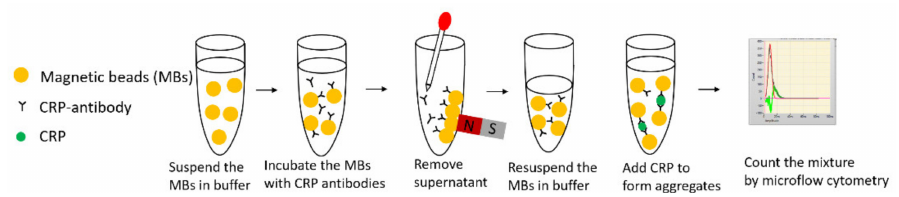
Figure 2. The principle of the